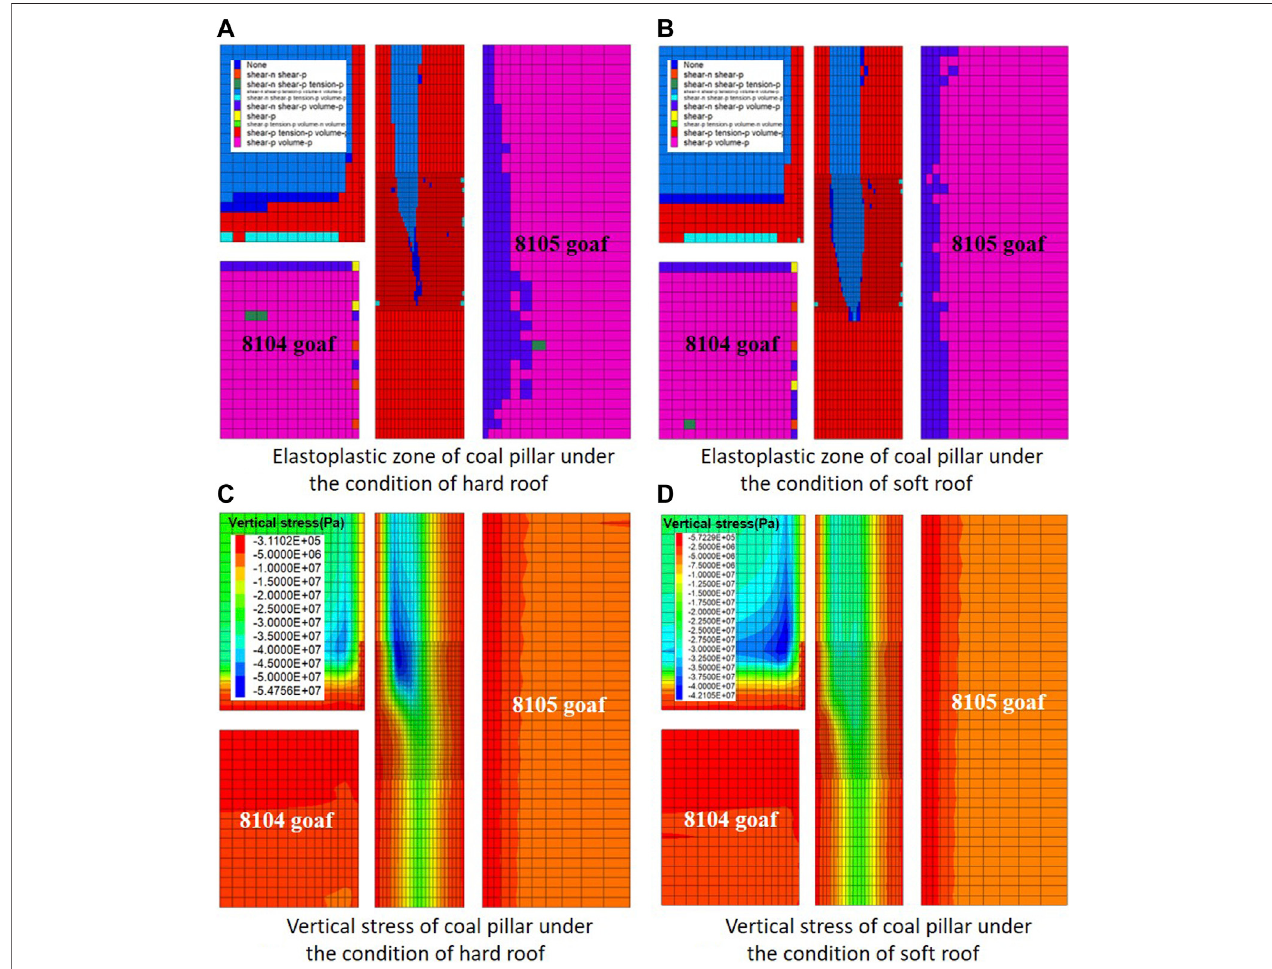
FIGURE 9 | Coal pillar stress and damage after secondary mining under different roof strength